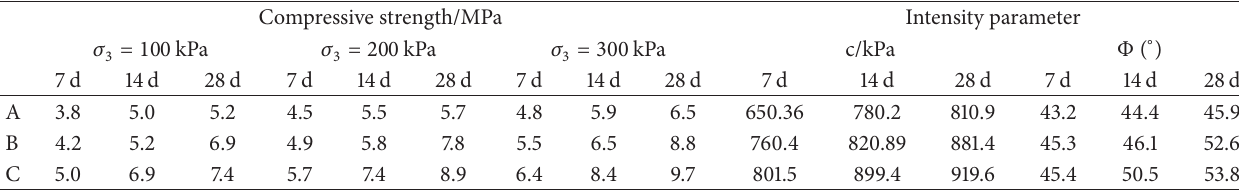
Table 6: The results of unconfined compressive strength and triaxial compressive strength